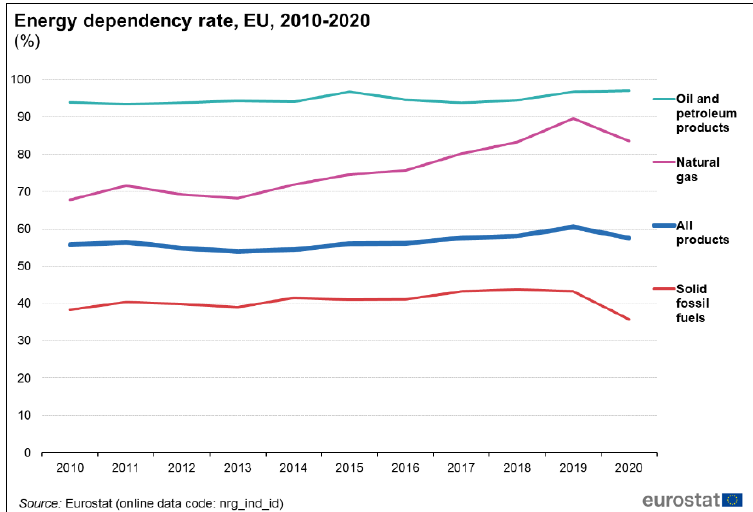
Figure 5. European Union energy dependency rate by source [44].